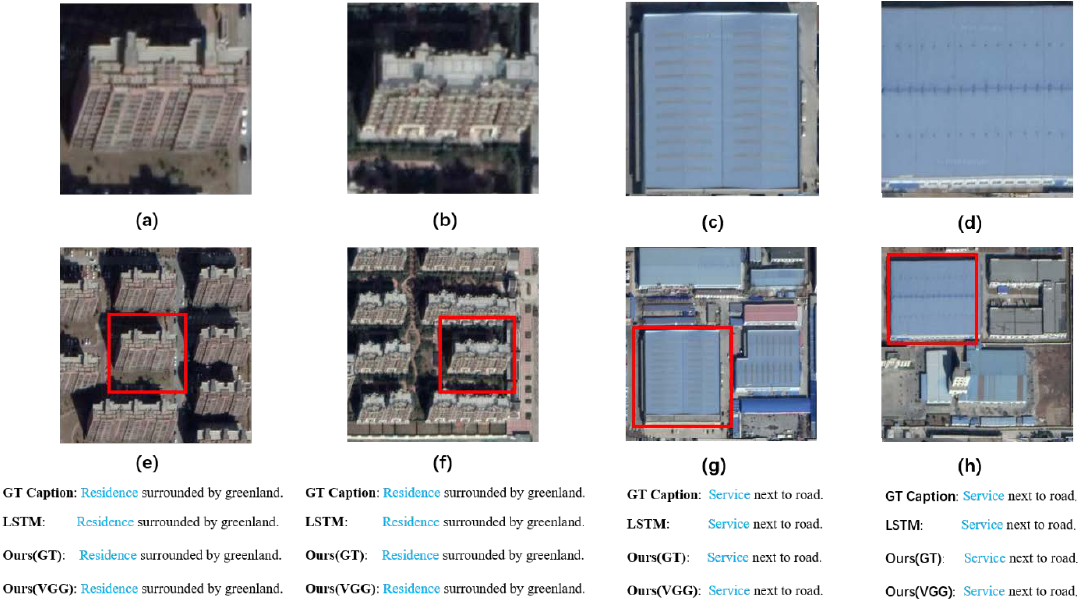
Figure 7. Demonstration of three networks’ performance on normal samples. ( a – d ) are four small-scale samples; ( e – h ) are corresponding large-scale samples of ( a – d ); ( a , b ) are a pair of normal sample; ( c , d ) are a pair of normal sample. The following sentences are GT caption sentence for small scale